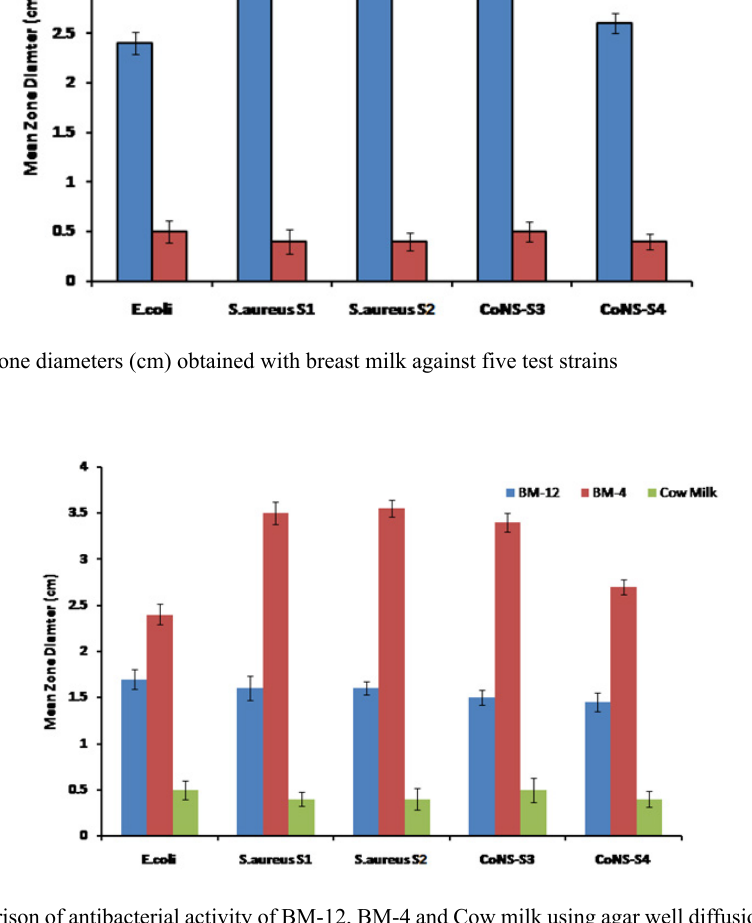
Fig. 2. Comparison of antibacterial activity of BM-12, BM-4 and Cow milk using agar well diffusion assay against all five test